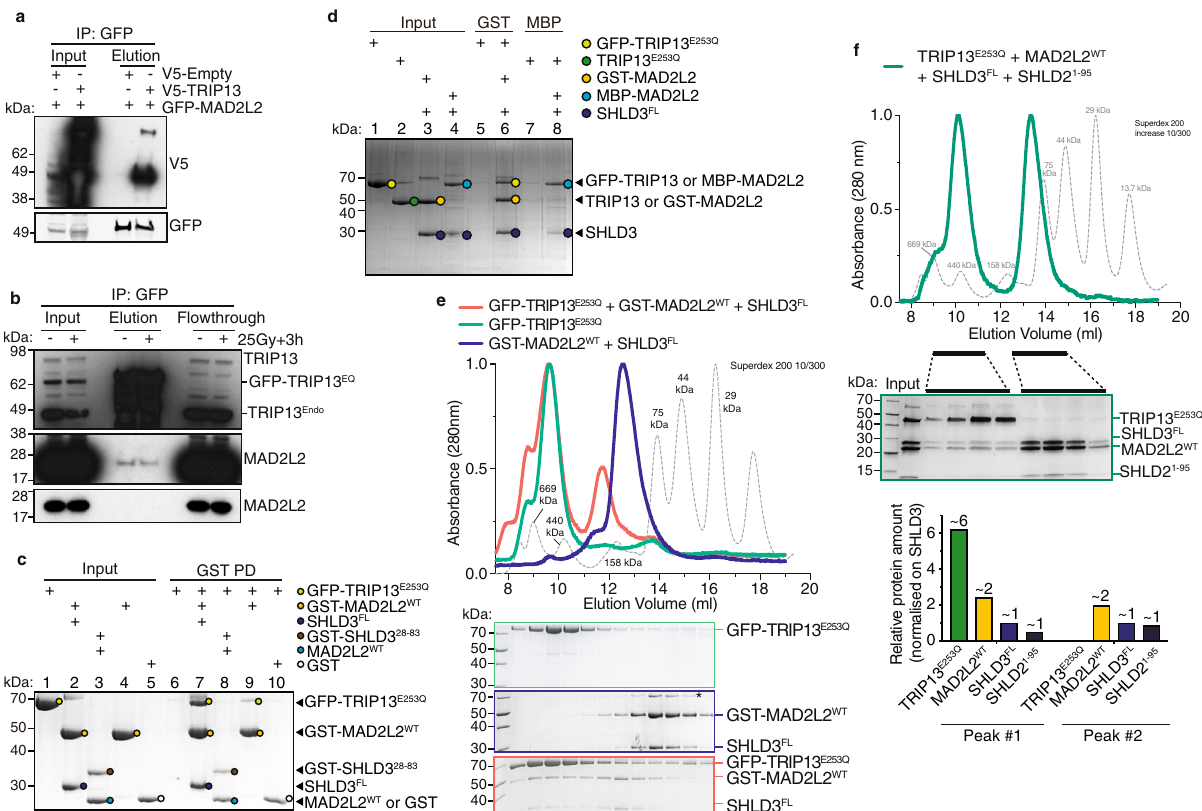
Fig. 3 TRIP13 interacts with dimerized MAD2L2 in shieldin. a Immunoblot of GFP-IP in 293T cells transfected with the indicated constructs. Representative of two independent experiments. b Immunoblot of GFP-IP in unirradiated or irradiated (25 Gy + 3 h) HeLa cells expressing dox-inducible GFP-tagged TRIP13-EQ. Representative of two independent experiments. c GST-tagged MAD2L2 in complex with full-length SHLD3 (lane 7) interacts directly with TRIP13 while the absence of SHLD3 strongly reduces the interaction with TRIP13 (lane 9). Representative of fi ve independent experiments. d Interaction with TRIP13 is dependent on MAD2L2 dimerization (induced here by a GST-tag, which is known to dimerize 61 ). GST-tagged MAD2L2 in complex with SHLD3 (lane 6), but not MBP-tagged MAD2L2 in complex with SHLD3 (lane 8), interacts directly with TRIP13. Representative of fi ve independent experiments. e TRIP13-MAD2L2-SHLD3 form a stable complex. Coomassie-stained SDS-PAGE gels of SEC pro fi les of TRIP13 (green), MAD2L2-SHLD3 (blue), and TRIP13-MAD2L2-SHLD3 (red). When mixed, the elution-pro fi les of TRIP13 and MAD2L2-SHLD3 shift to an apparent higher molecular weight, indicative of complex formation. MAD2L2-SHLD3 can interact to both the monomer TRIP13 and the hexamer TRIP13. All experiments were performed in presence of 0.1 mM ATP. Asterisk denotes contaminant. Molecular weights of GST-MAD2L2 is 52 kDa, of SHLD3 is 29 kDa and of GFP- TRIP13 is 75.5 kDa (453 kDa for hexamer). Representative of three experiments. f MAD2L2-SHLD3-SHLD2 1-95 interacts stably with a TRIP13 E253Q hexamer. Coomassie-stained SDS-PAGE gels of SEC pro fi le of TRIP13-MAD2L2-SHLD3-SHLD2 1-95 . Proteins were mixed in equimolar concentrations. All experiments were performed in the presence of 0.1 mM ATP to induce hexamerisation of TRIP13 E253Q . Molecular weights are: MAD2L2 = 24 kDa, SHLD3 = 29 kDa, SHLD2 1-95 = 10.3 kDa, and TRIP13 E253Q = 48.5 kDa (291 kDa for hexamer). Representative of fi ve experiments. Source data are provided as a Source Data fi ef fi ciency in a DR-GFP reporter assay (Fig. 4e and Supplementary